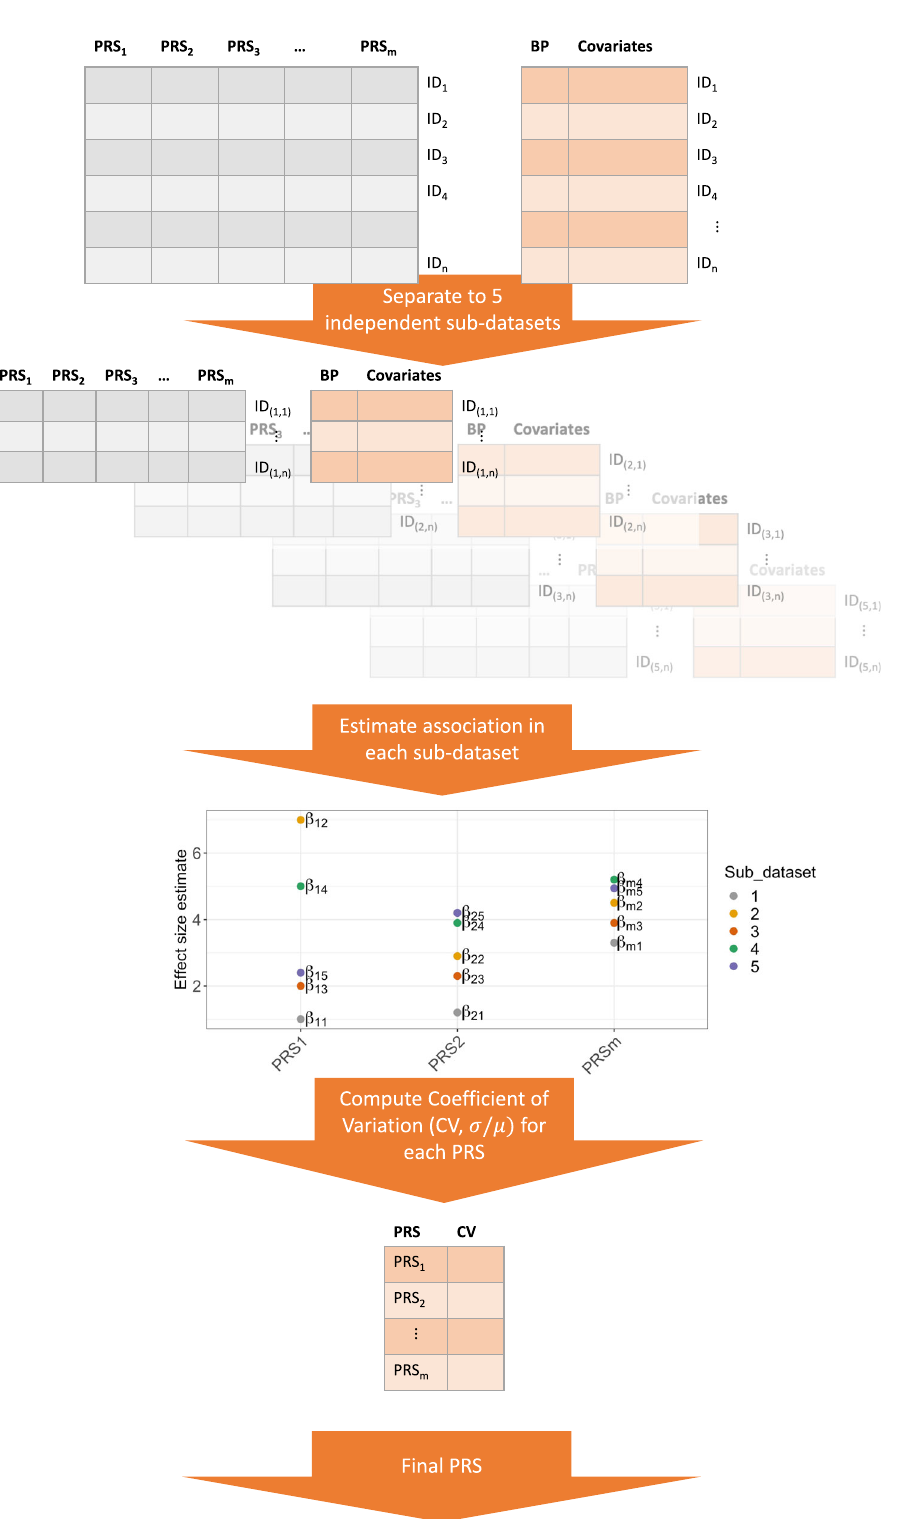
Fig. 7 PRS selection using coef fi cient of variation work fl ow. Flowchart describing the selection of PRS according to the coef fi cient of variation (CV) criterion. The data set is split into fi ve independent sub-datasets (without related individuals between the subsets). An association model is fi t on each sub- dataset for each PRS. Each PRS, de fi ned by a unique combination of tuning parameter, has 5 independent effect size estimates. We compute the CV for each such PRS, and select the PRS that minimizes the